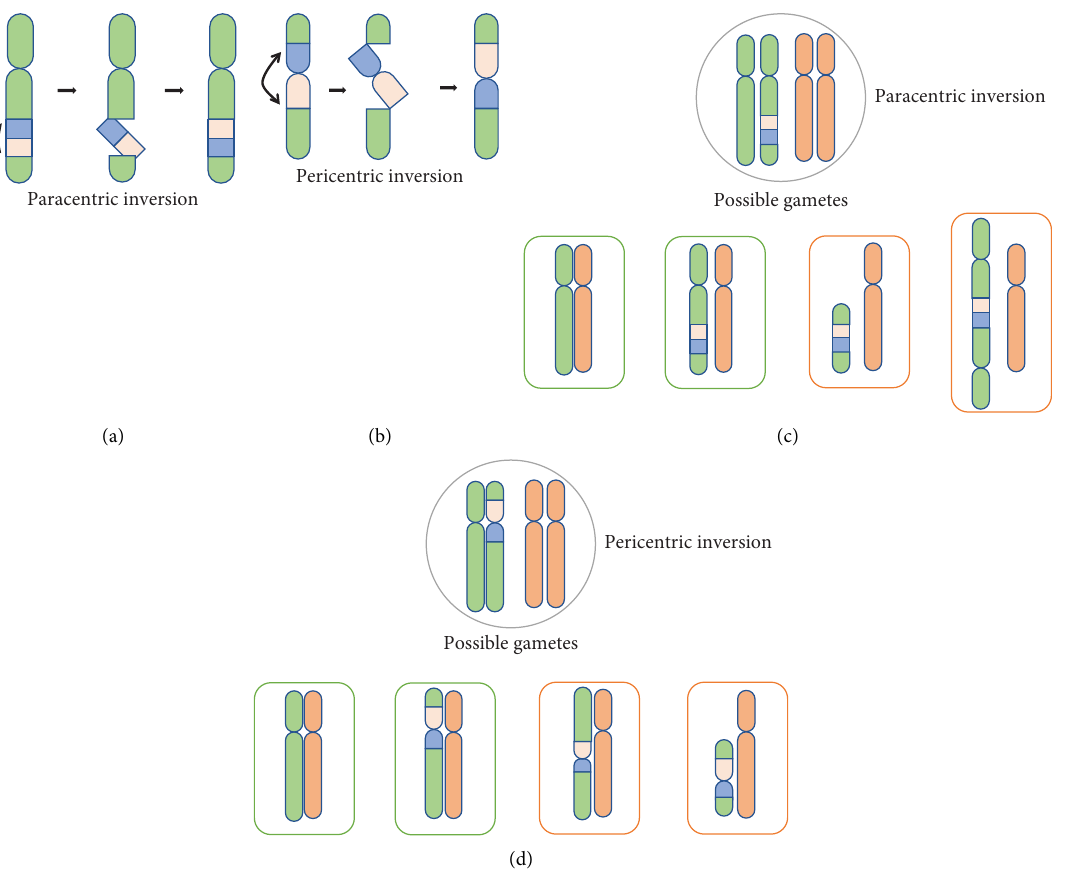
Figure 3: Chromosomal inversions: two breaks in the same chromosome, causing the resulting fragments to reconnect after 180 degrees of reversal. (a) Paracentric inversion: the inverted segments do not contain chromosomes. (b) Pericentric inversion: the inverted segments contain chromosomes. (c) Possible gametes of paracentric inversion. In meiosis, a crossover between a normal chromosome and an inverted chromosome results in the loss or duplication of a segment of the gametophyte chromosome, leading to chromosome abnormality and abnormal traits in the ofspring. Balanced gametes are designated by the green border. Unbalanced gametes are designated by the red border. (d) Possible gametes of pericentric inversion. Balanced gametes are designated by the green border. Unbalanced gametes are designated by the red